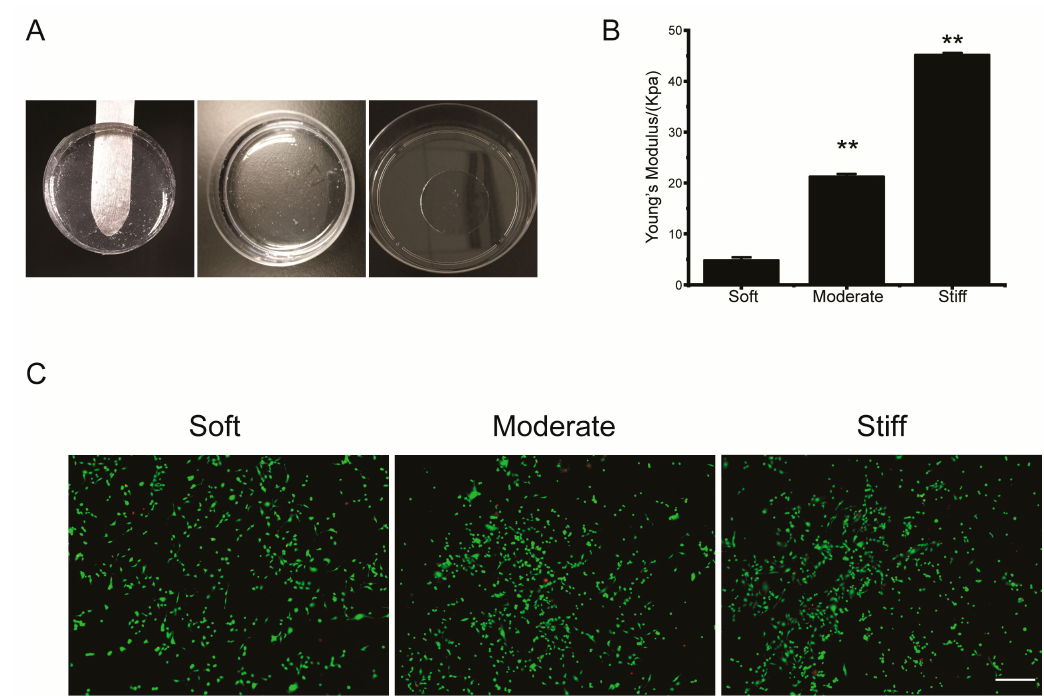
Figure 1. Polyvinyl alcohol (PVA) hydrogels showed sti ff ness controllable mechanical properties and were not cytotoxic. ( A ) PVA hydrogels were fabricated in di ff erent molds. ( B ) Sti ff ness of PVA hydrogels were tested by atomic force microscopy (AFM). Data were presented as the mean ± SEM ( n = 30). ** represents p < 0.01. ( C ) Live / dead assay for hepatocytes cultured on soft, moderate, and sti ff substrates. Representative fluorescence images of live / dead cell staining. Calcein-AM (green) indicates live cells, while PI (red) indicates dead cells. Scale bar = 40 µ